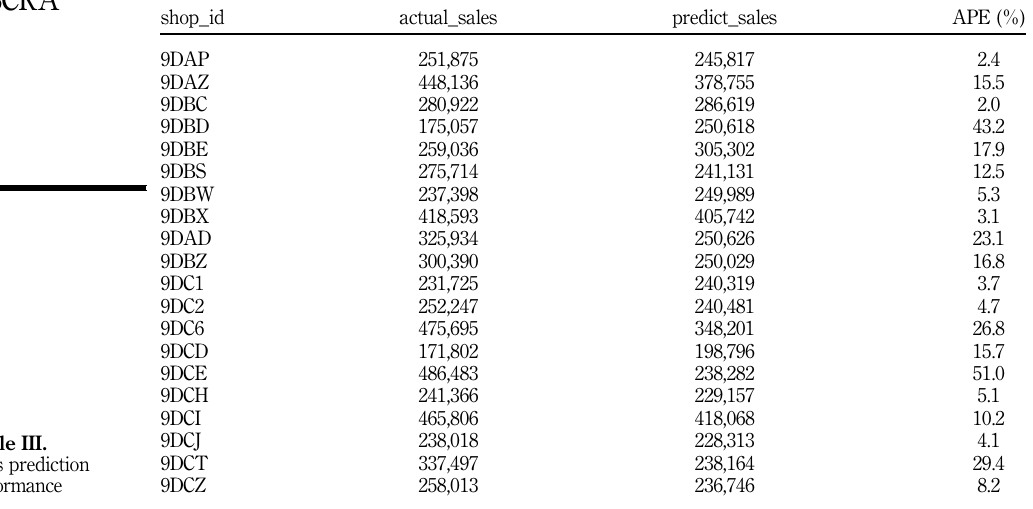
Table III. Sales prediction